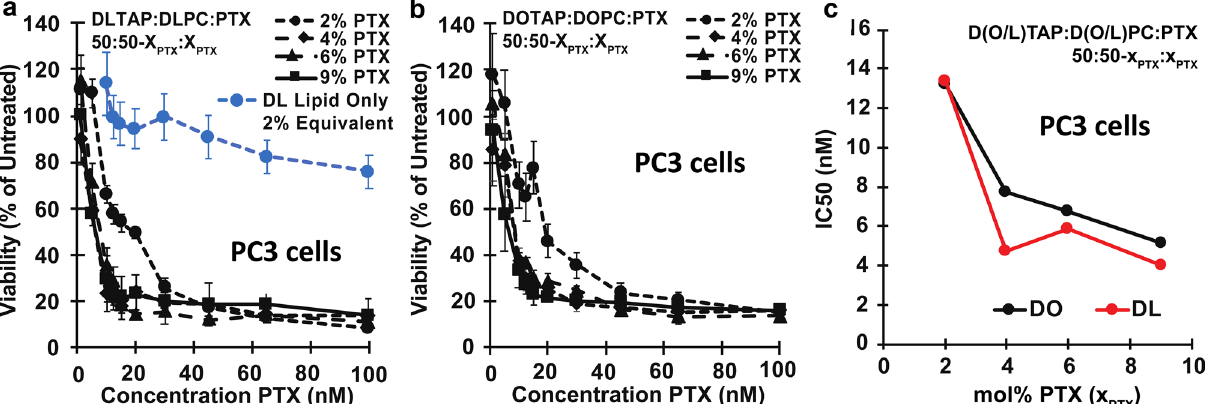
Figure 7. Cytotoxicity of PTX-loaded CLs against PC3 cells. ( a ) Viability of PC3 cells (relative to untreated cells) as a function of PTX concentration for cells treated with CLs of a molar composition of 50/50–x PTX / x PTX , DLinTAP/DLinPC/PTX, with x PTX = 2, 4, 6, or 9 (black lines). Cell viability rapidly decreased with PTX concentration to a plateau. As a control, DLinTAP/DLinPC CLs without PTX were added to PC3 cells in amounts that match the lipid content of CLs with x PTX = 2 (which have the highest lipid content) at the PTX concentrations tested (blue line). This CL-only control showed no appreciable cytotoxicity (≥ 90% viability) up to the lipid equivalent of 65 nM PTX delivered with a 2 mol% PTX formulation, demonstrating that PTX and not lipid drove cytotoxicity at the IC50 of every formulation. ( b ) Viability of PC3 cells (relative to untreated cells) as a function of PTX concentration for cells treated with control CLs of a molar composition of 50/50– x PTX /x PTX , DOTAP/DOPC/PTX, with x PTX = 2, 4, 6, or 9 (black lines). Cell viability rapidly decreased with PTX concentration to a plateau. Previous work has shown that CLs alone do not contribute to cytotoxicity at the employed concentrations 48 . ( c ) Plot of IC50 values for PTX cytotoxicity against PC3 cells for the CL formulations based on lipids with linoleoyl (“DLin”, red line) and oleoyl (“DO”, black line) tails. Each IC50 was determined by fitting the corresponding cell viability curve (from parts a and b ) as described in the Methods section. The IC50 decreases (efficacy increases) with increasing PTX content in both DOTAP/DOPC/PTX and DLinTAP/DLinPC/PTX formulations. The efficacy of DLinTAP/DLinPC/PTX CLs is higher than that of DOTAP/DOPC/PTX CLs at all PTX contents except 2 mol%, but difference is not significant. This shows that replacing oleoyl with linoleoyl tails maintains cytotoxic efficacy against PC3 cells while increasing PTX membrane solubility (Fig.